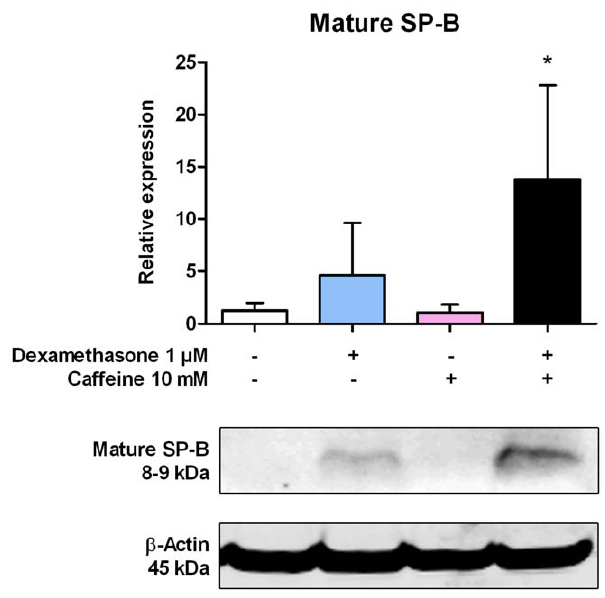
Figure 6. Influence of dexamethasone and caffeine on expression of mature SP-B. H441 cells were treated with 1 m M dexamethasone, 10 mM caffeine, or combinations. After 48 h, cells were lysed and Western immunoblotting analysis against SP-B was performed using a polyclonal antibody. Relative expression levels of SP- B were calculated by normalizing signals to detected b -actin levels. Whereas in untreated cells or cells treated with 10 mM caffeine no mature SP-B could be detected, the expression of mature SP-B in H441 cells was modestly induced by dexamethasone and significantly induced in cells additionally treated with caffeine. Data represent means 6 SD of n=3 independent experiments. * p , 0.05 compared to control